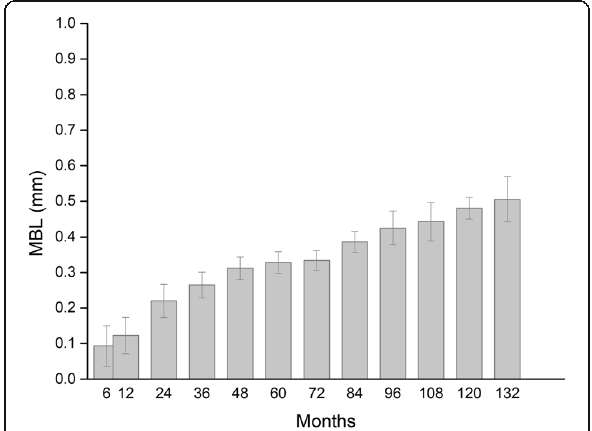
Fig. 4 Histologic of a biopsy taken from the case shown in Figs. 2 and 3 (position 17). × 10 magnification. Particles of residual biomaterial (darker, blue-violet areas) are embedded within newly formed bone (lighter, purple areas)